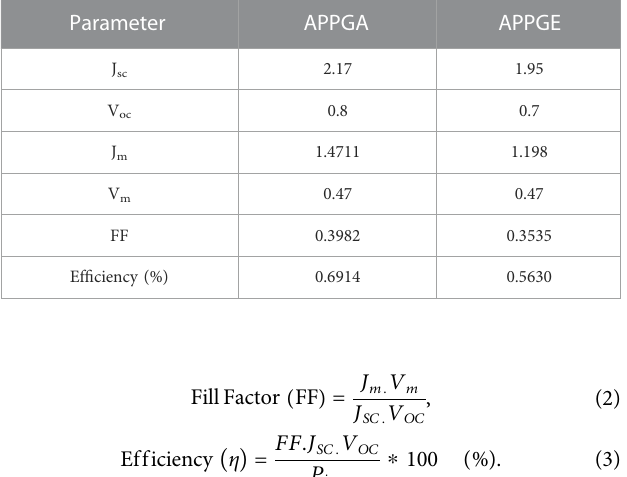
TABLE 2 List of parameters evaluated for DSSC with APPGA and